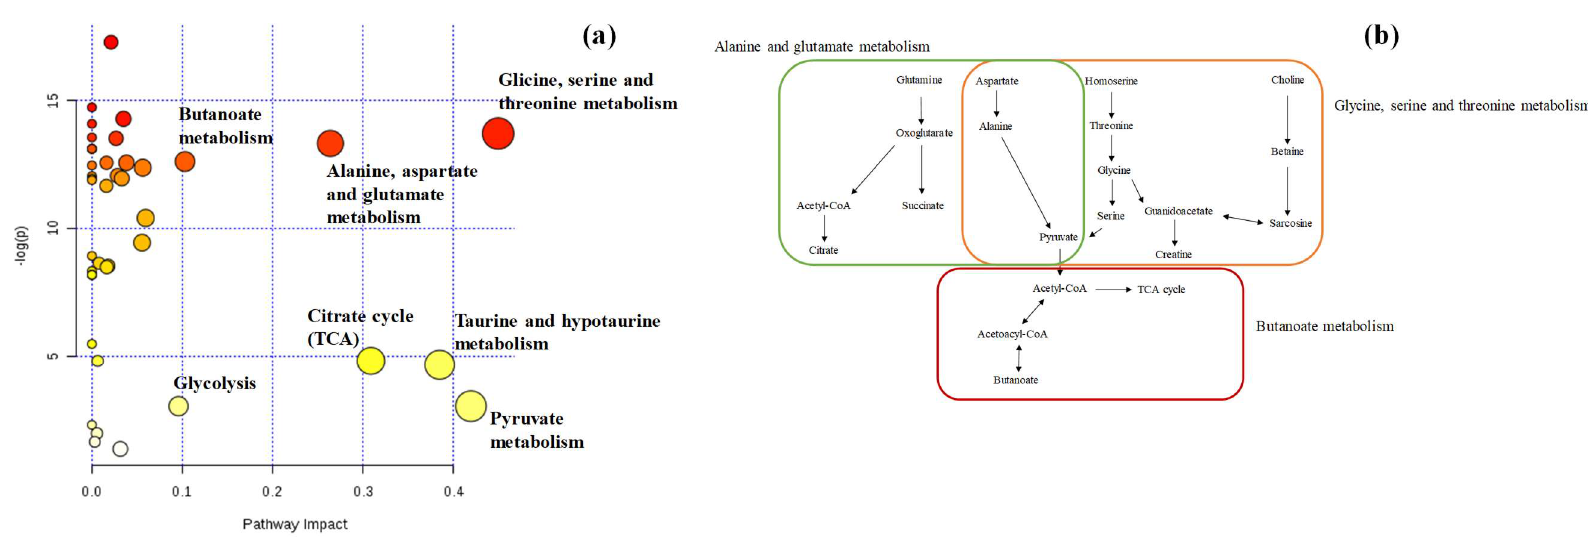
Figure 7. ( a ) The metabolome view map of significant altered metabolic pathways observed in urine from BC and CTL groups, and ( b ) metabolic pathways ( x -axis) with highest impact that include the most promising potential BC biomarkers identified in this study.